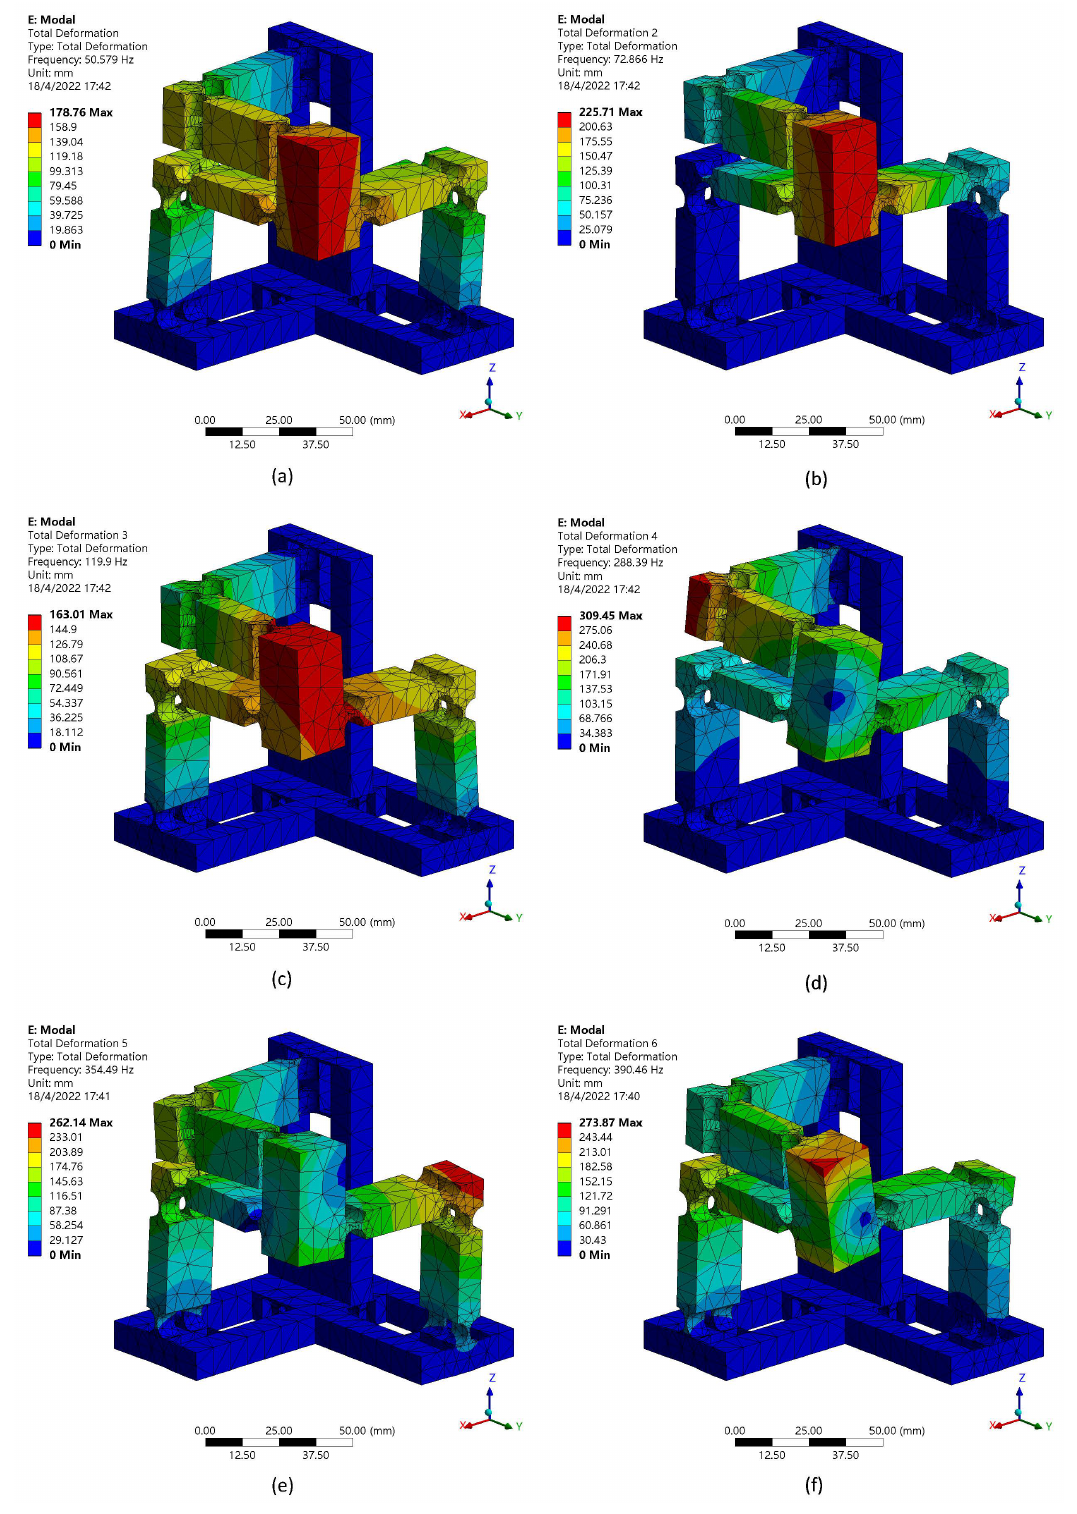
Figure 12. First six mode shapes: ( a ) mode 1, ( b ) mode 2, ( c ) mode 3, ( d ) mode 4, ( e ) mode